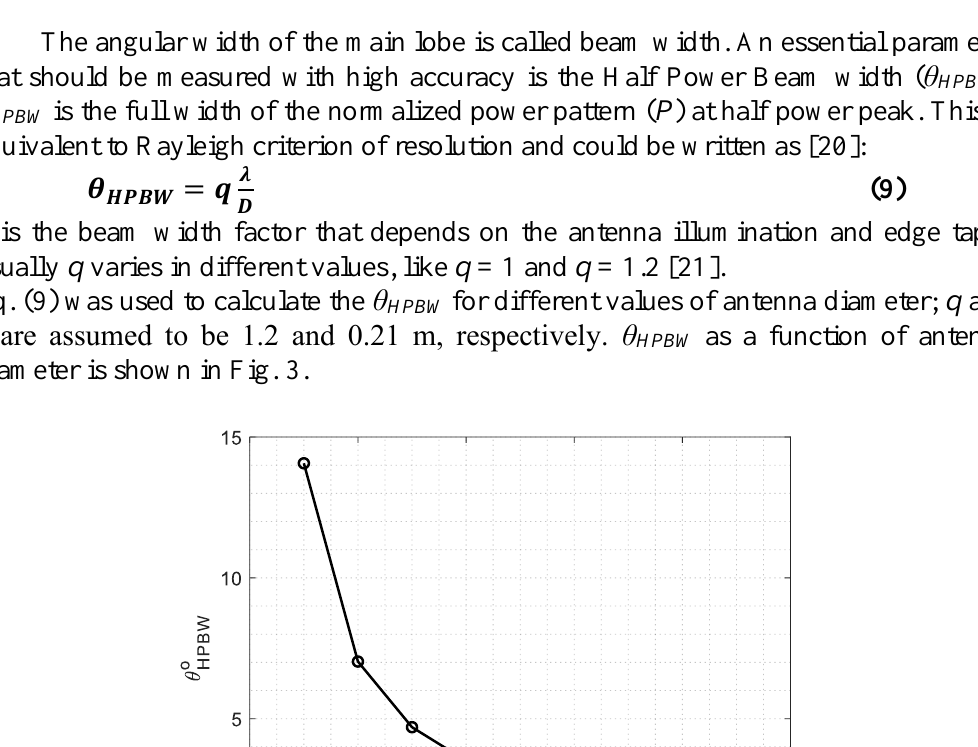
Figure 3: Half Power beam width (θ